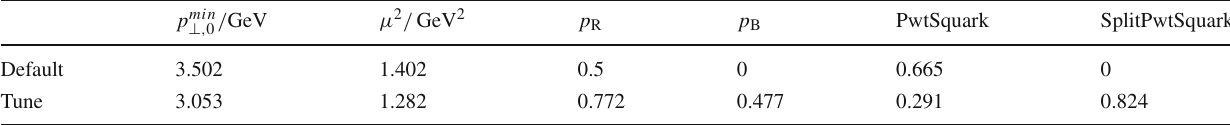
√ s = 7TeV centre-of-mass